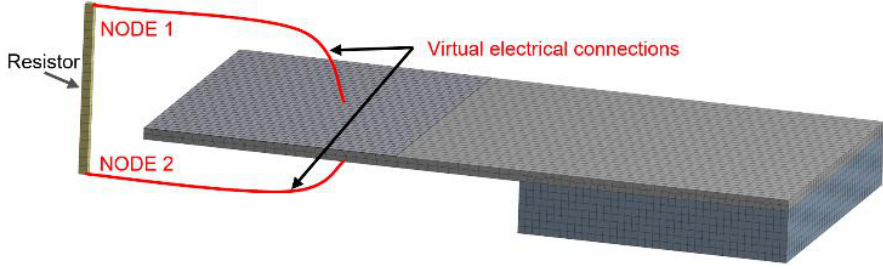
Figure 6. Scheme of PEH model with electrically connected R L .